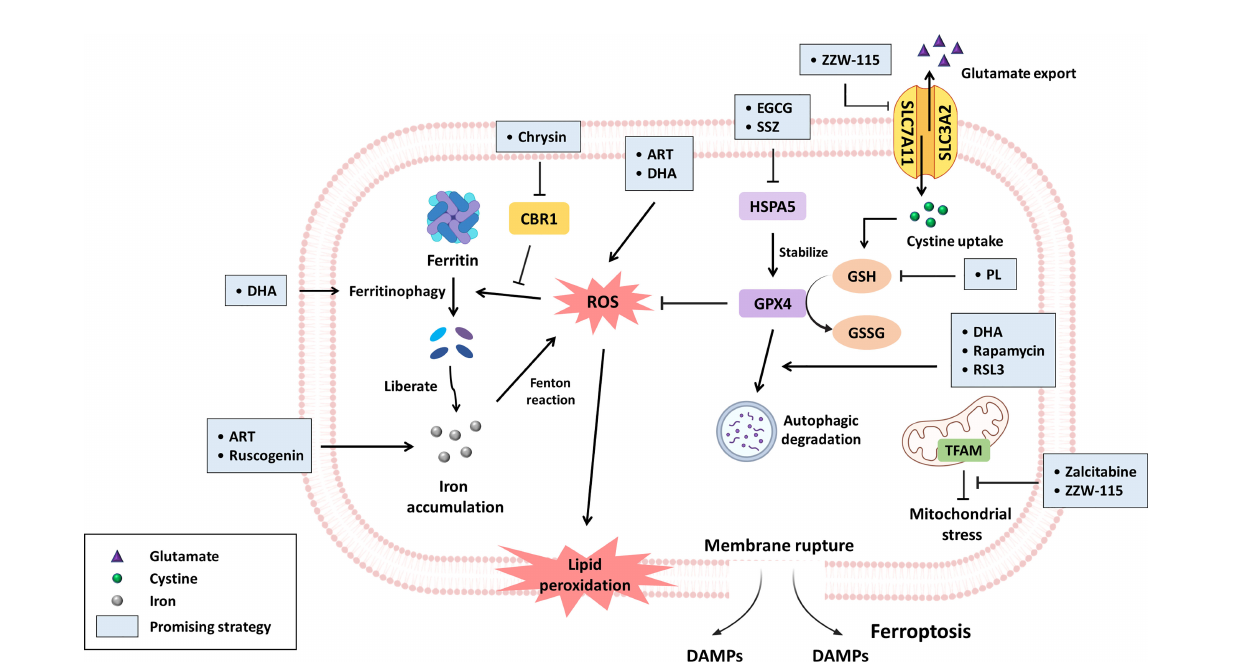
FIGURE 1 | The promising compounds for inhibiting PDAC progression via ferroptosis induction. Ferroptosis is primarily initiated through iron accumulation, increased ROS production and lipid peroxidation. With regard to iron accumulation, DHA induces ferritinophagy, and chrysin promotes ROS-mediated ferritinophagy by inhibiting CBR1 expression; in this context, both ART and ruscogenin can contribute to increased intracellular iron levels. Regarding oxidative stress, ART and DHA have been reported to increase ROS generation. GPX4, an important negative modulator of ROS, is stabilized by HSPA5. Nevertheless, EGCG and SSZ have been suggested to block HSPA5, subsequently subverting GPX4 stability. Furthermore, DHA, rapamycin and RSL3 can drive the autophagic degradation of GPX4. GSH synthesized from cystine is a key antioxidant that circumvents ferroptosis, but the product of PL hydrolysis can inhibit GSH generation. SLC7A11 is a subunit of systemic Xc- that facilitates cystine uptake for GSH synthesis, while ZZW-115 downregulates SLC7A11 expression. Zalcitabine and ZZW-115 disrupt TFAM, which is responsible for mtDNA homoeostasis, leading to mitochondrial stress concomitant with lipid peroxidation. Taken together, the aforementioned compounds can induce ferroptosis in PDAC mainly by modulating iron or redox homoeostasis. The promising strategies are highlighted by light blue